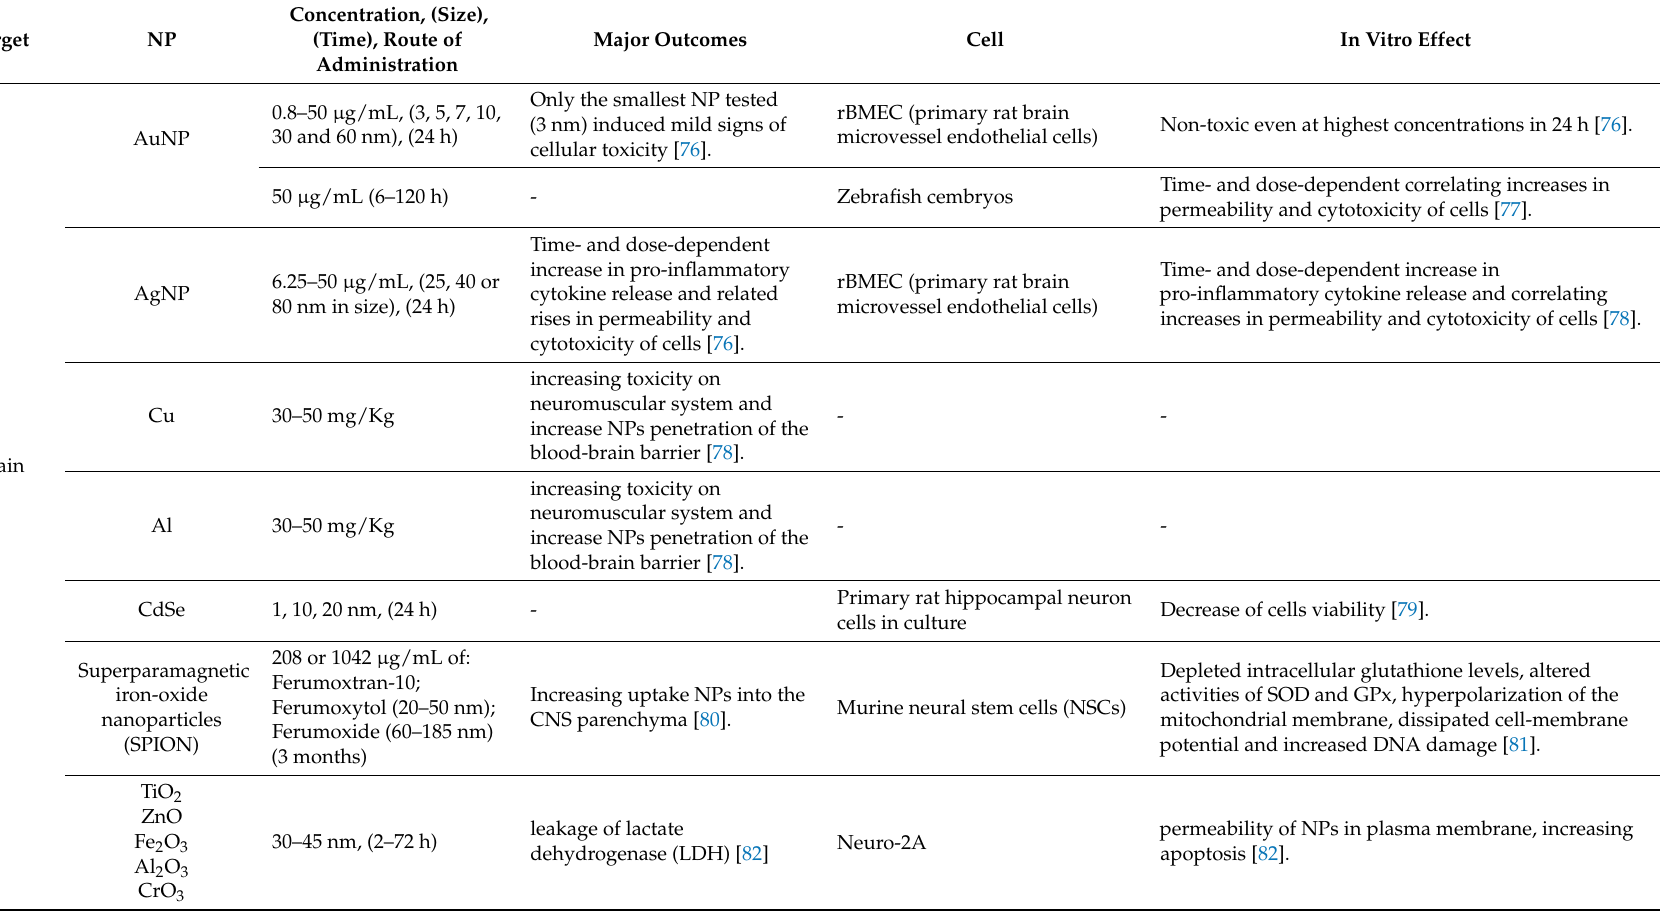
Table 1. Toxic effects of nanoparticles on different